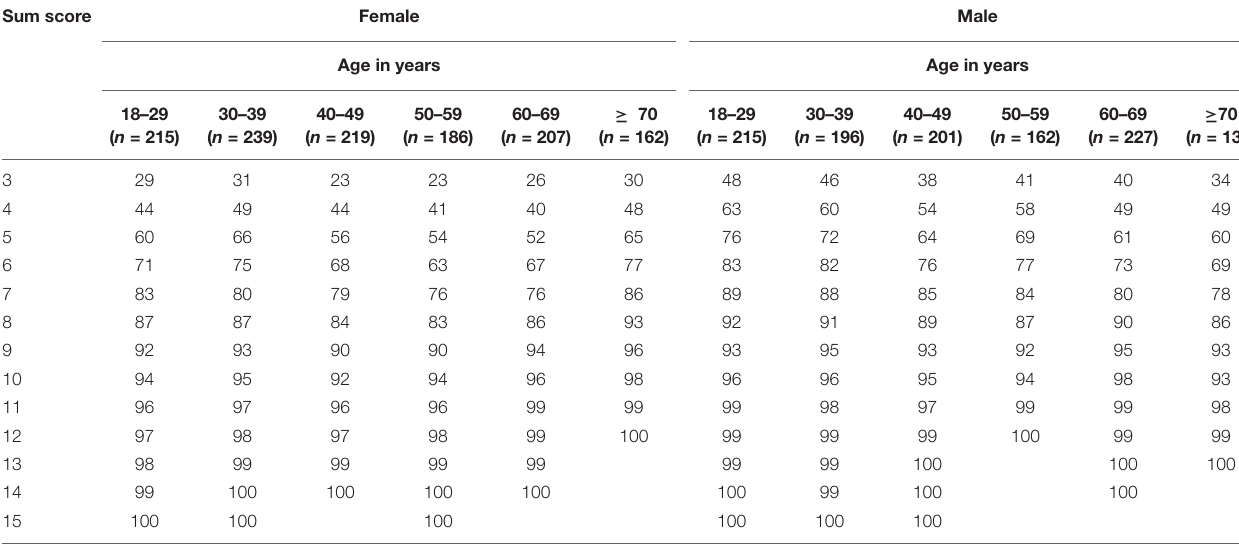
TABLE 7a | Normative percentile ranks for the RBI real